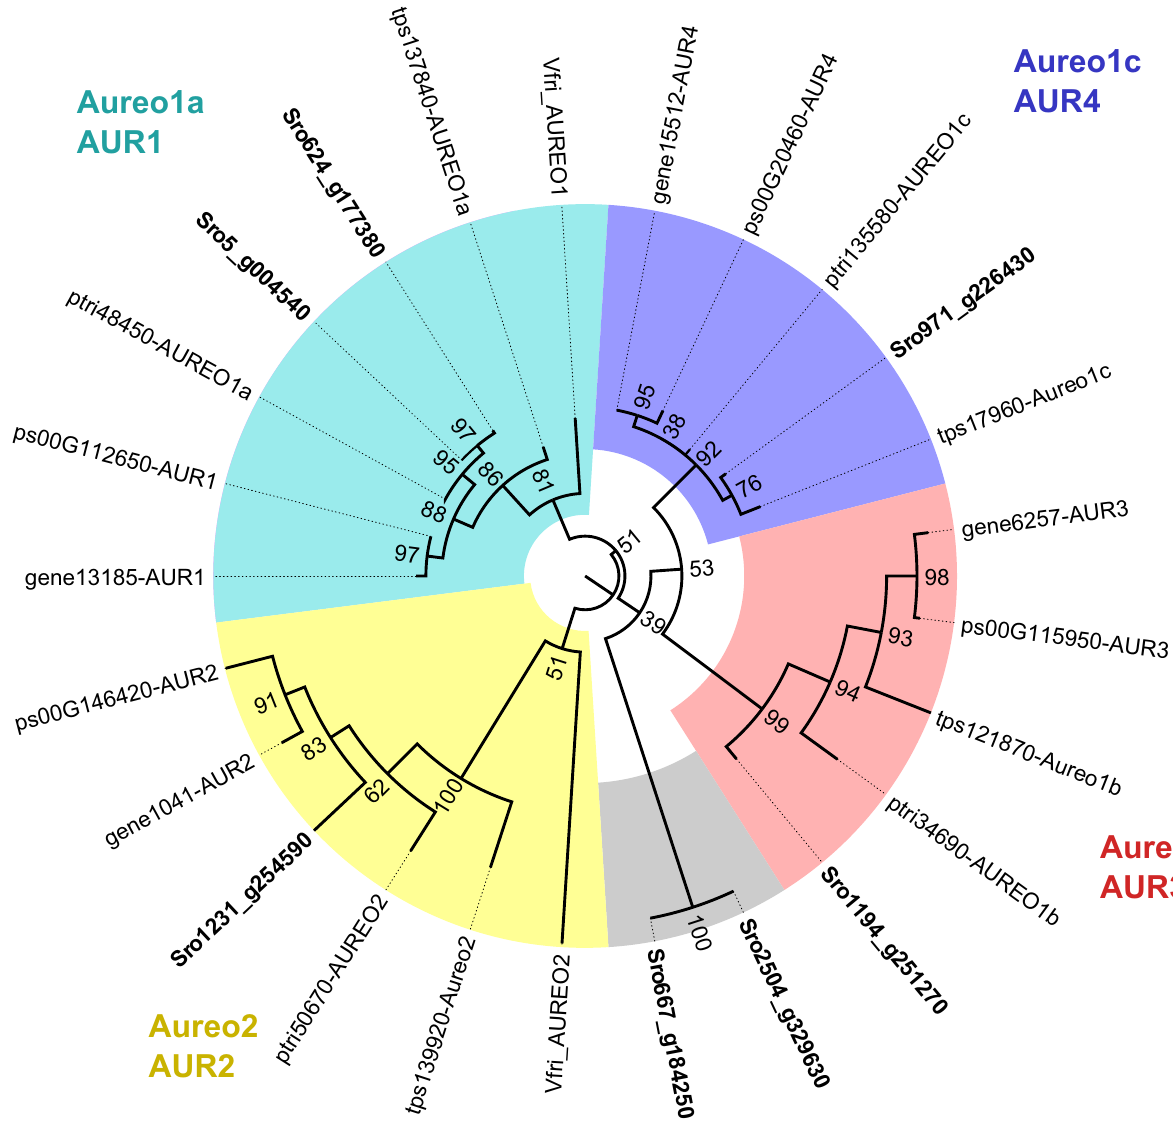
Figure 4. Circular maximum likelihood phylogenetic tree of aureochrome protein sequences. S. robusta homologs (“Sro”, in bold) are clustered in relation to previously annotated aureochromes from the diatoms Phaeodactylum tricornutum (“ptri”), Thalassiosira pseudonana (“tps”), Fragilariopsis cylindrus (“gene”) and Pseudo-nitzschia multiseries (“ps”) as well as the xanthophyte Vaucheria frigida (“Vfri”). The four recognized clades are indicated by colours, and both the clade designation (AUR) and name of the P. tricornutum homolog in each clade (Aureo) are indicated at the outside of the tree. Two atypical S. robusta aureochromes that did not cluster with one of the clades are indicated in grey. The phylogenetic tree was midpoint rooted and bootstrap values are indicated in each